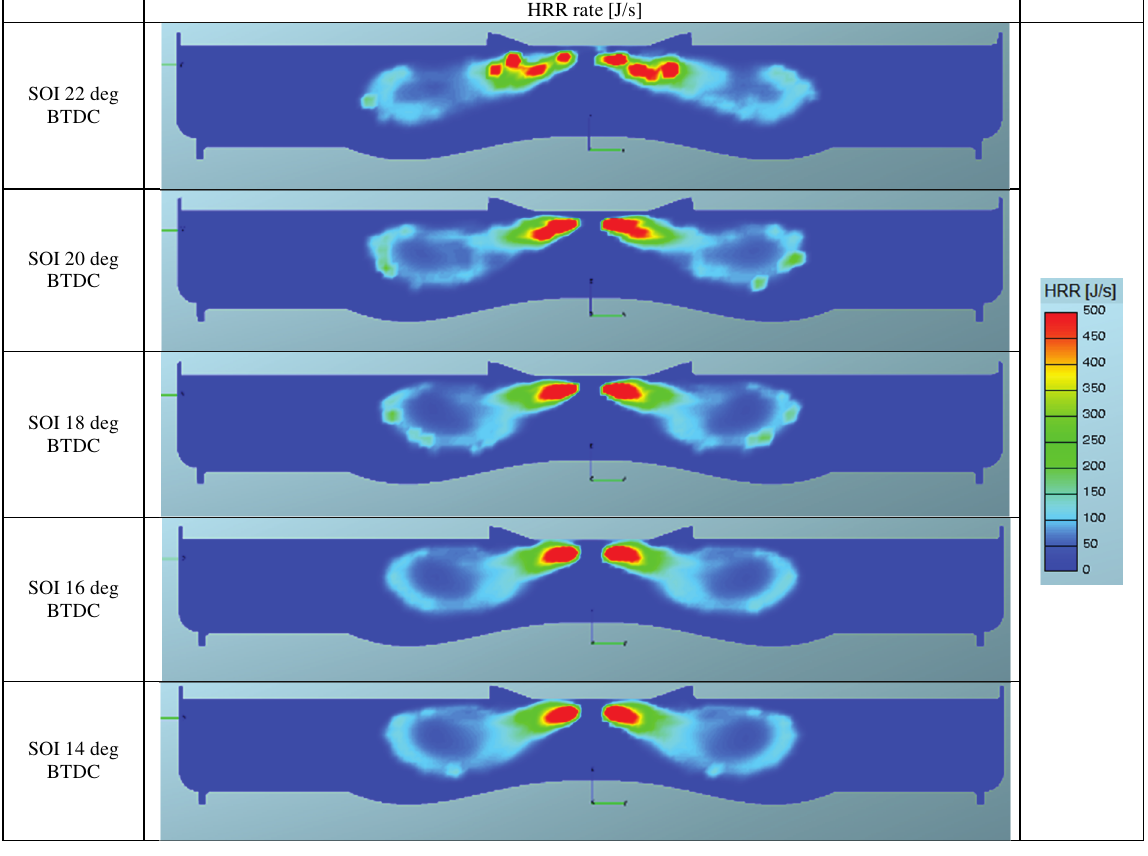
Fig. 3. Heat release rate distribution in the combustion chamber at 12 degrees of the crankshaft position after the